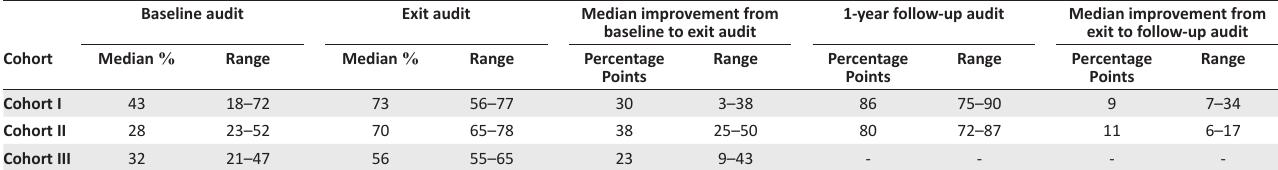
TABLE 1: Cohort-level audit scores.